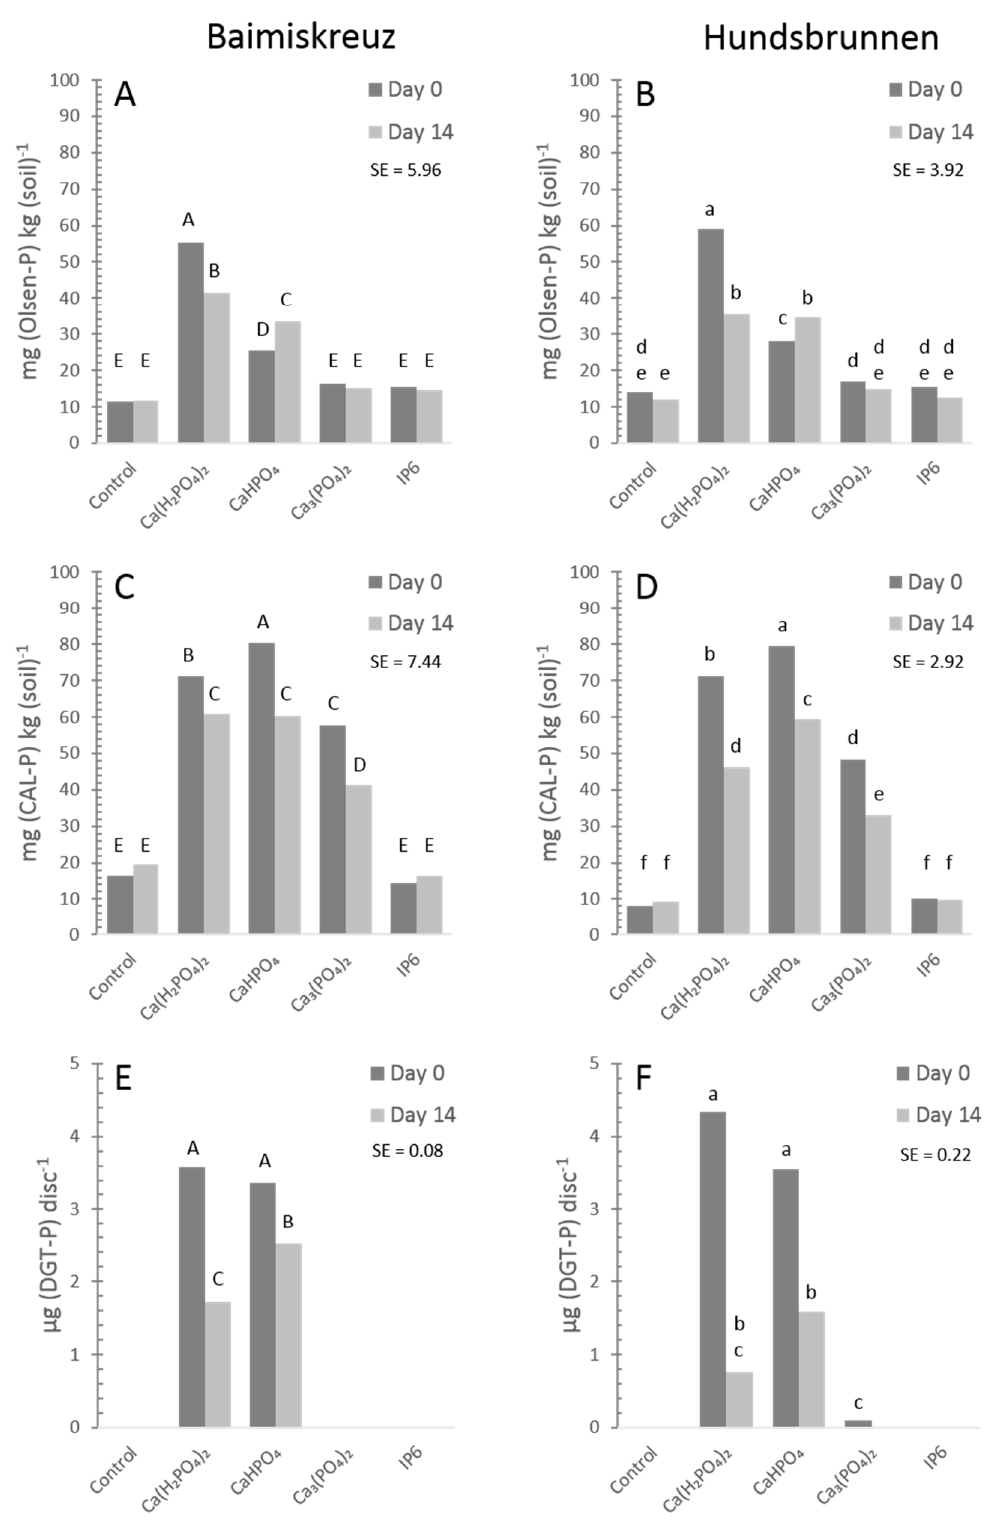
Figure 2. Olsen ( A , B ), calcium acetate/lactate (CAL) ( C , D ) and DGT ( E , F ) extracted P from the experimental soils Baimiskreuz (pH 6.4) ( A , C , E ) and Hundsbrunnen (pH 7.4) ( B , D , F ) after the addition of 100 mg (P) kg (soil) − 1 . Where no bars are depicted, P concentrations were below the analytical detection limit. Letters above bars indicate significant differences between observations (P source × time, TukeyHSD, α = 0.05) evaluated for each soil separately, SE indicates the pooled standard error.